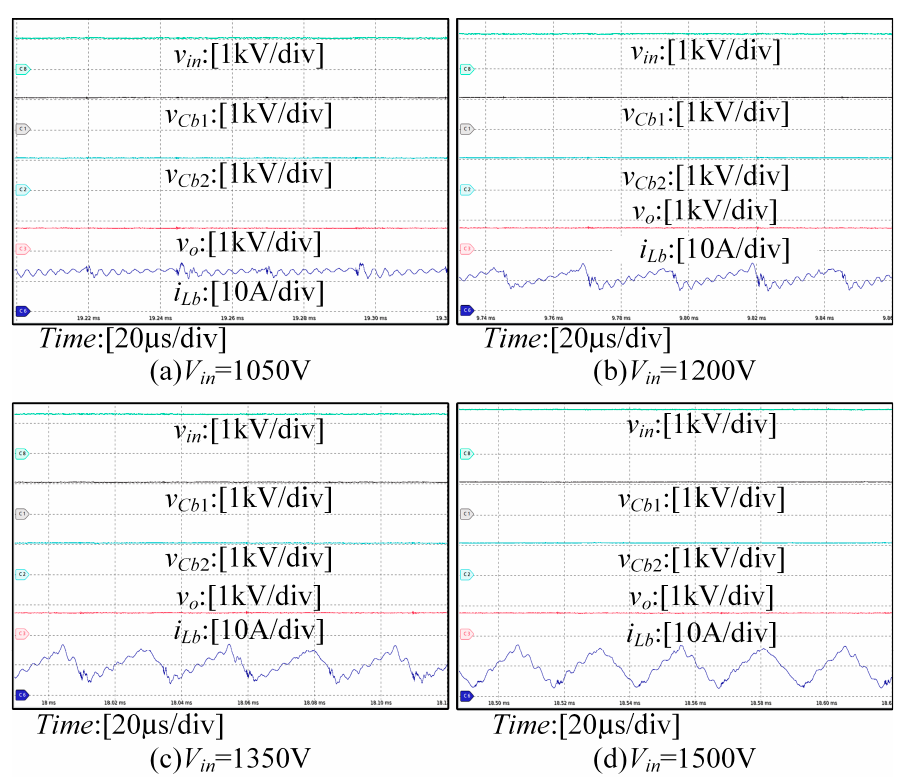
Figure 15. Experimental waveforms at different input voltages.